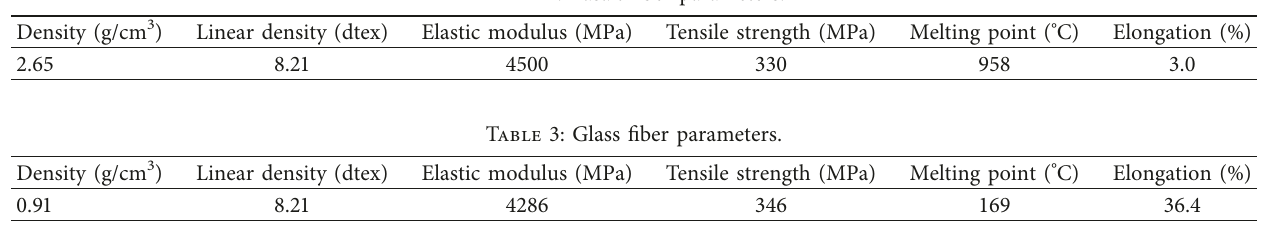
Figure 2: Material diagram. (a) Glass fiber. (b) Basalt fiber. Table 2: Basalt fiber parameters.